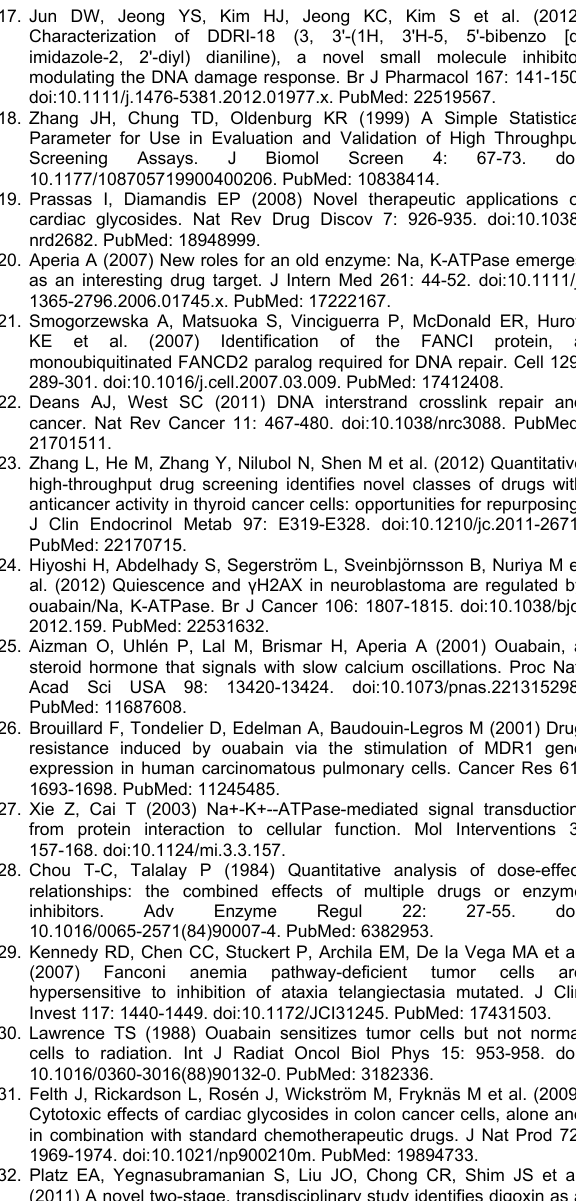
Table S1. List of selected chemicals that inhibit FA-BRCA